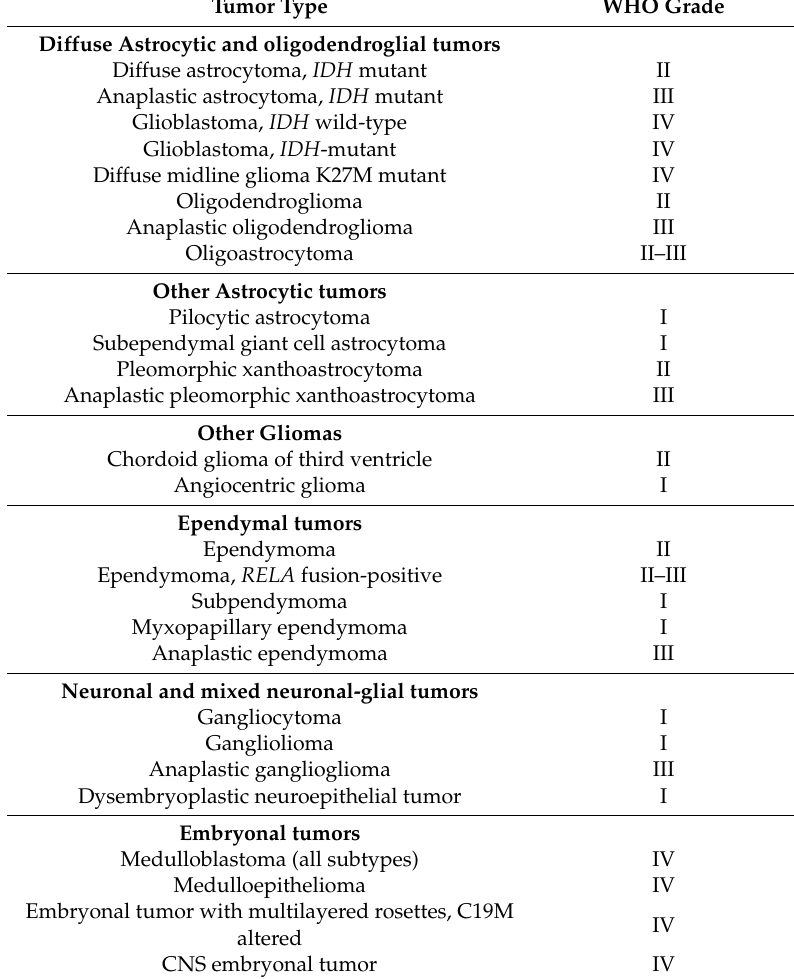
Table 1. World Health Organization (WHO) histological classification of tumors of the central nervous